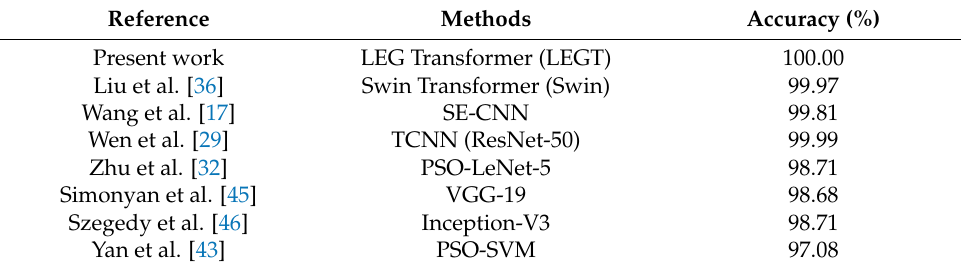
Table 6. Comparative results published in the literature.